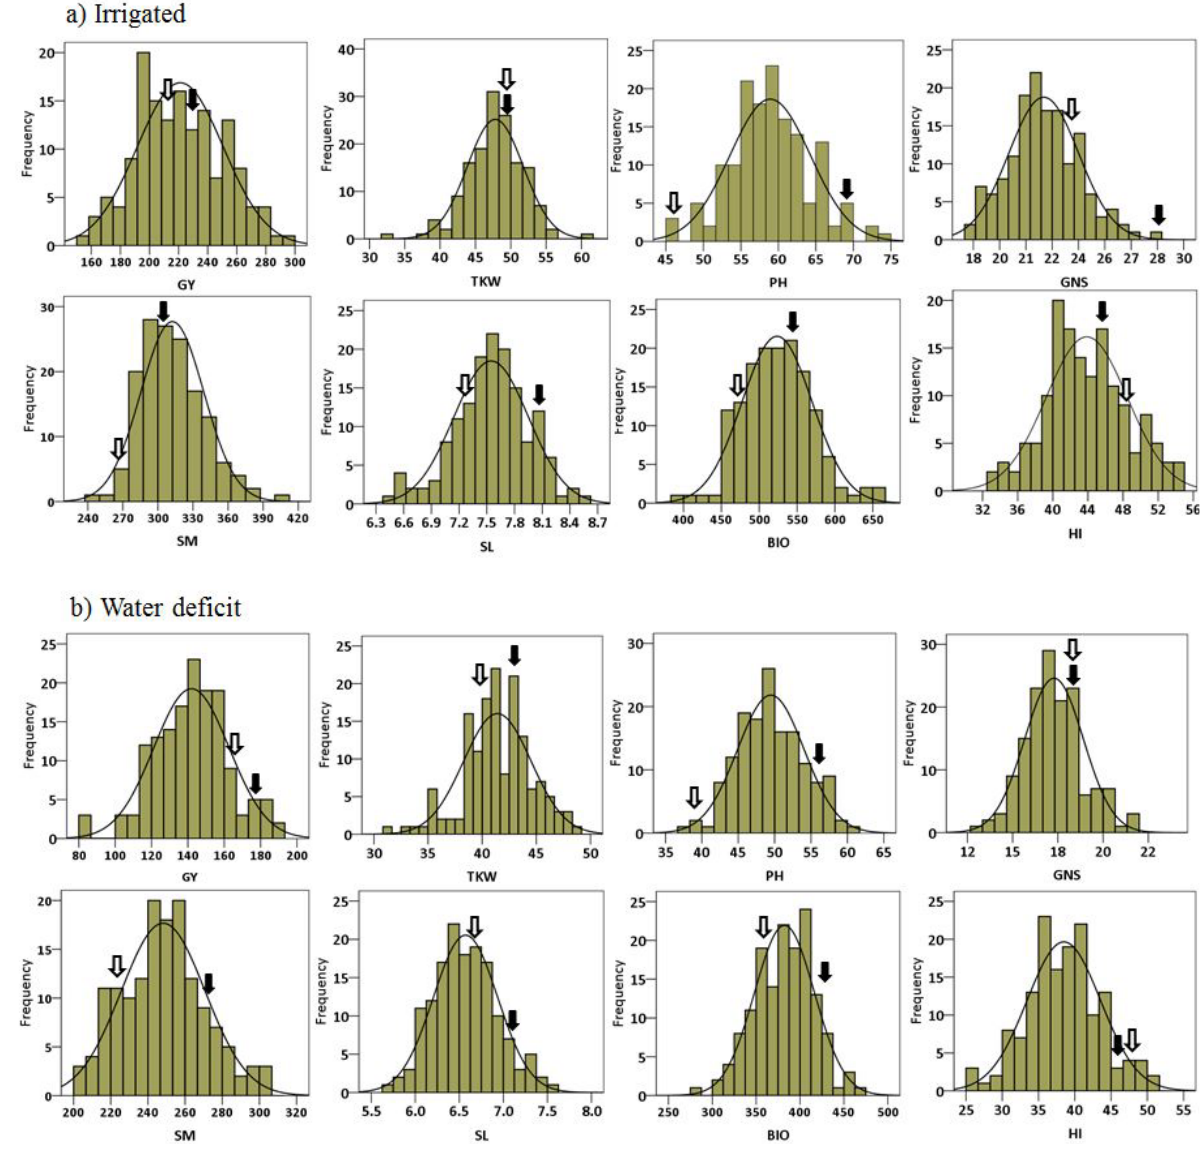
Figure 1. Frequency distribution of averaged phenotypic data of three locations and two years for all traits recorded: under irrigated ( a ); and water deficit ( b ) conditions. #49 and Yecora Rojo are shown by a filled and unfilled arrow, respectively. Table 1. Pearson’s correlation coefficients between studied traits under irrigated and water deficit conditions.